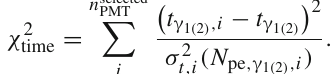
Fig. 11 Energy response to MC 2 γ events with E true γ = 12 MeV. The blue curves are the PDFs fit to the distributions. E true γ 2 See text for the formula of the